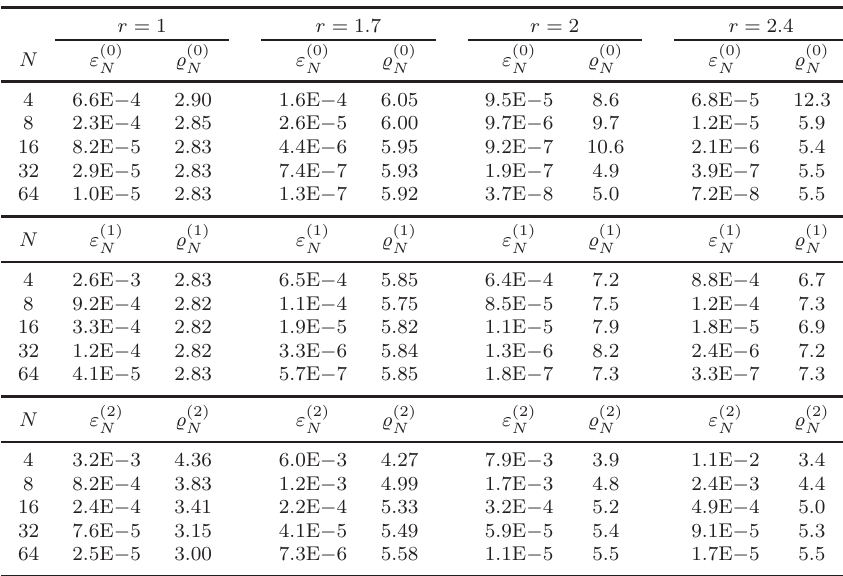
Table 1. Results in the case m = m 1 = 2 , η 1 = ξ 1 = (3